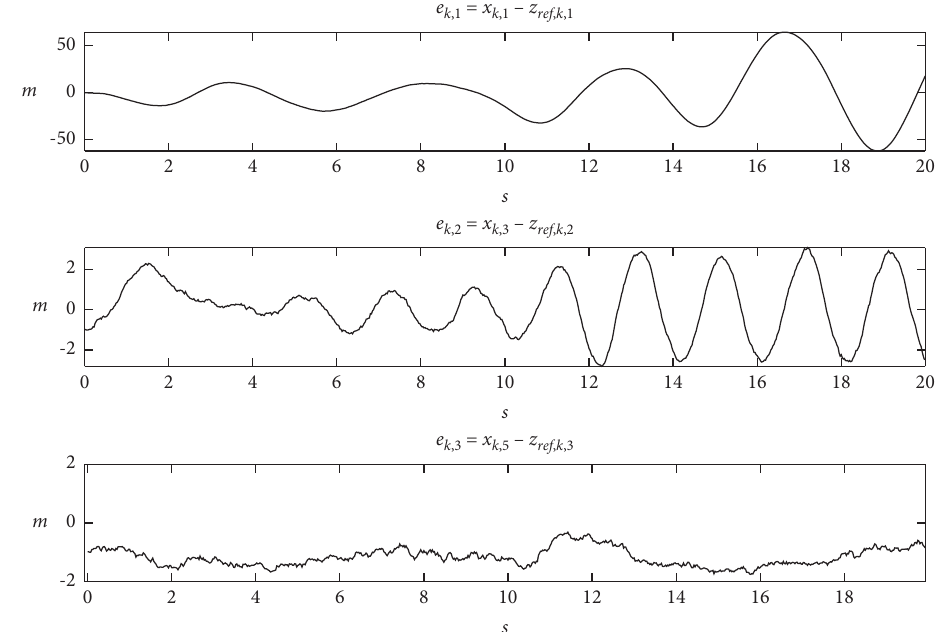
Figure 9: Tracking errors for random references considering the structure